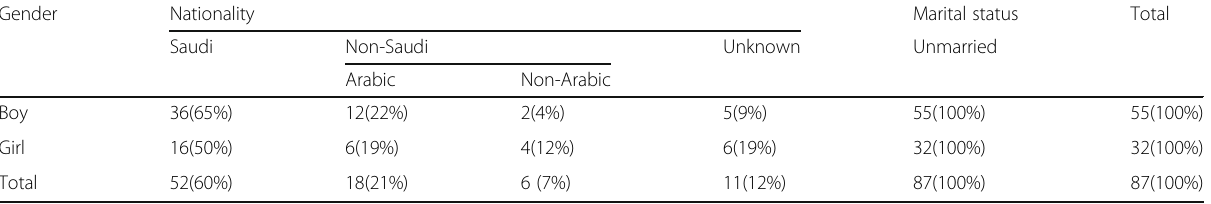
Table 1 Distribution of questionable child deaths according to their gender, nationality, identity and marital status Gender Nationality Marital